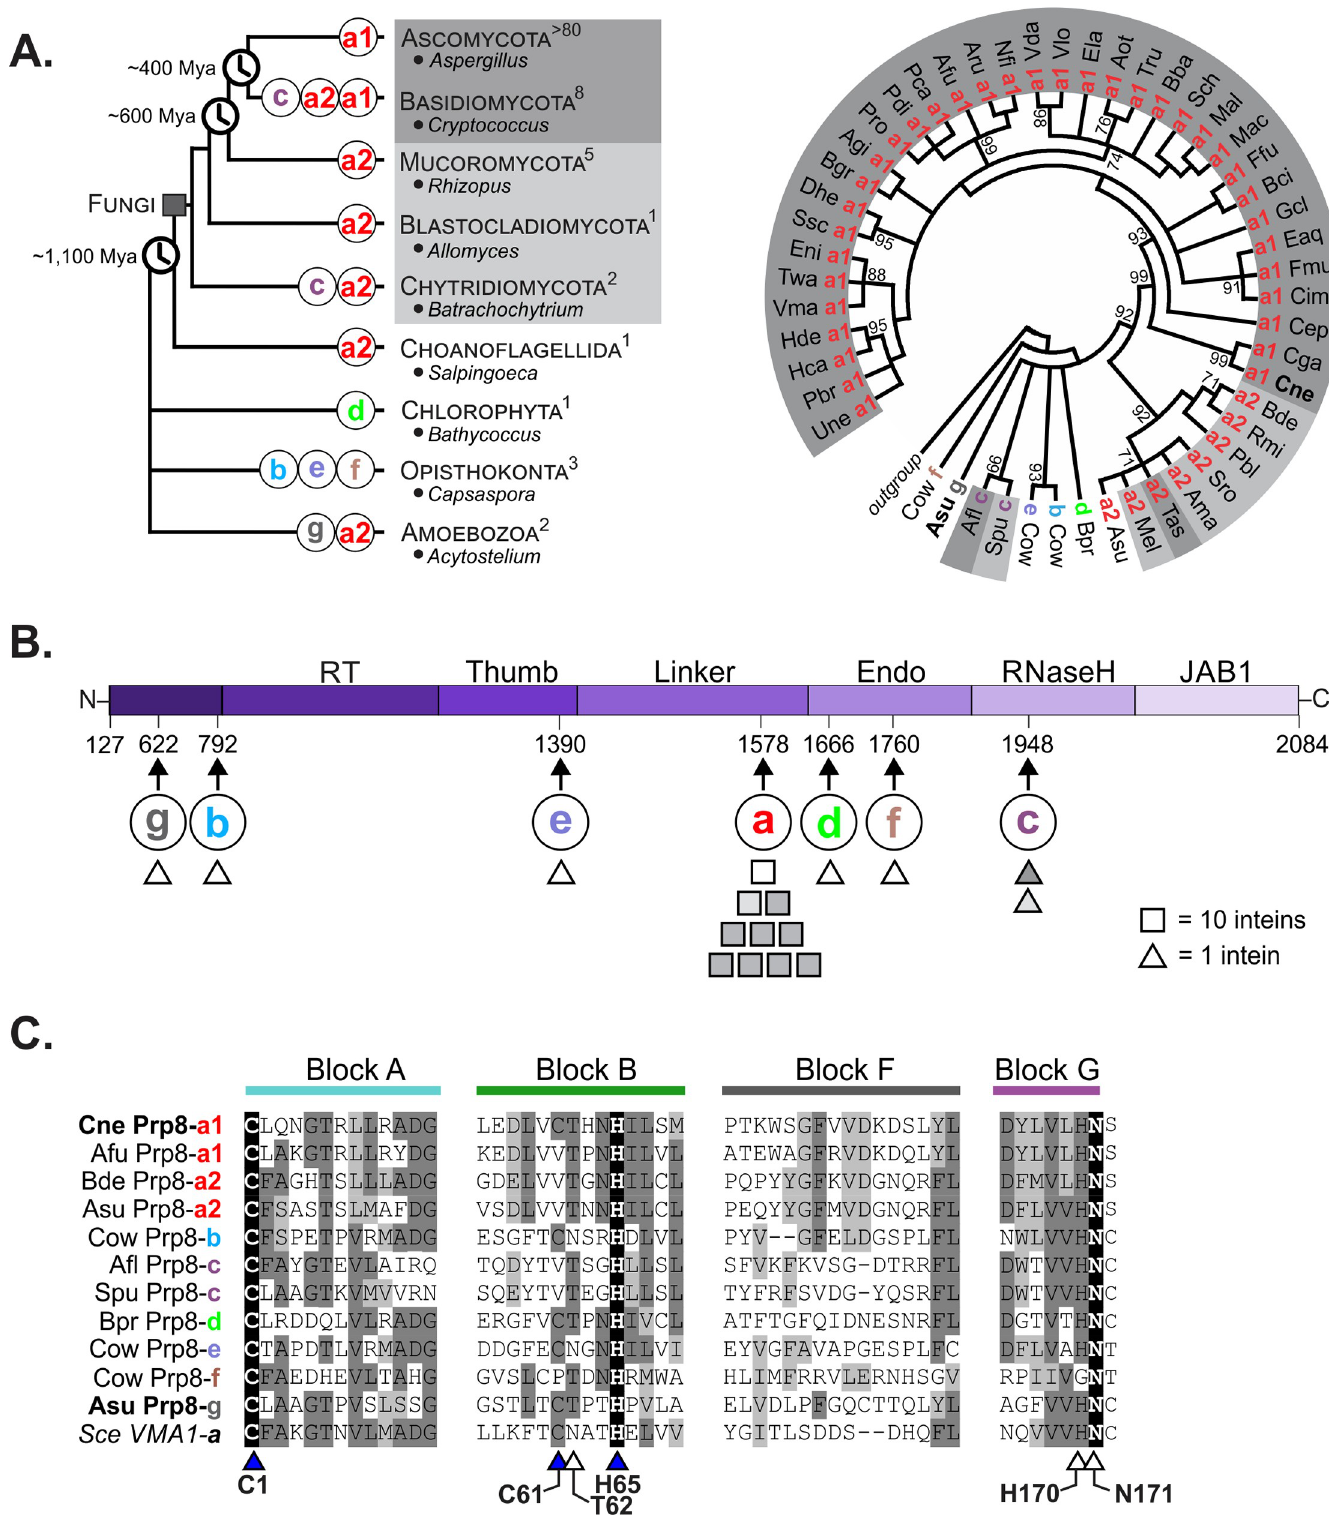
Fig 1. Prp8 is an intein hot spot with multiple, independent insertion sites. (A) Modified phylogenetic tree of eukaryotes (left) shows the phyla that contain Prp8 inteins, with representative genera listed. Evolutionary divergence times are denoted in mya. The number of Prp8 inteins in each phylum is shown in superscript, and